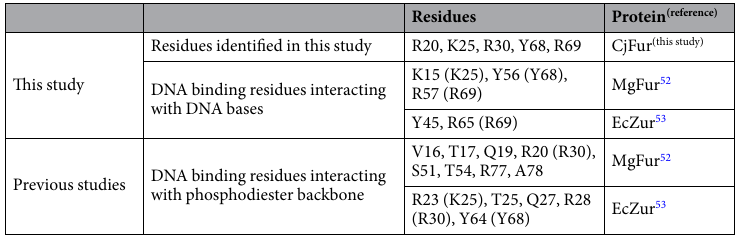
Table 3. Summary of DNA binding residues identified in this study and those involved in contacting DNA identified in the crystal structures of Fur/DNA and Zur/DNA complexes. Residues in brackets correspond to CjFur residues identified in this